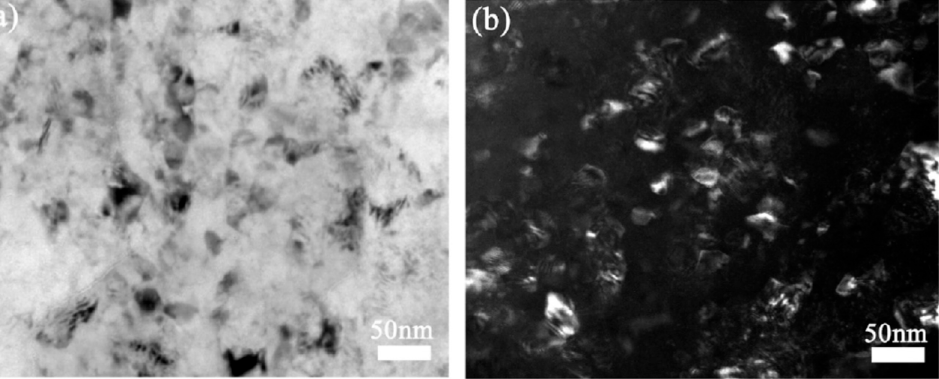
Figure 5. TEM images of the structure of an Mg–8.2Gd–3.8Y–1.0Zn–0.4Zr alloy processed via HPT [30].